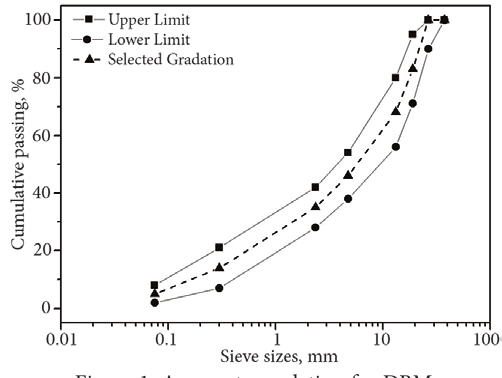
Figure 1. Aggregate gradation for DBM Table 2. Test results of VG-30 bituminous